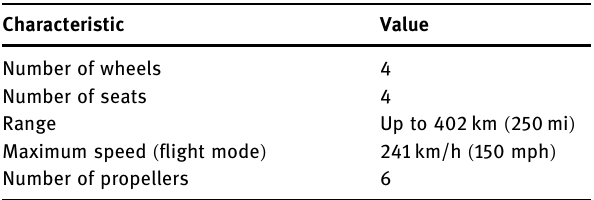
Table 4: Some characteristics of ASKA ™ Flying